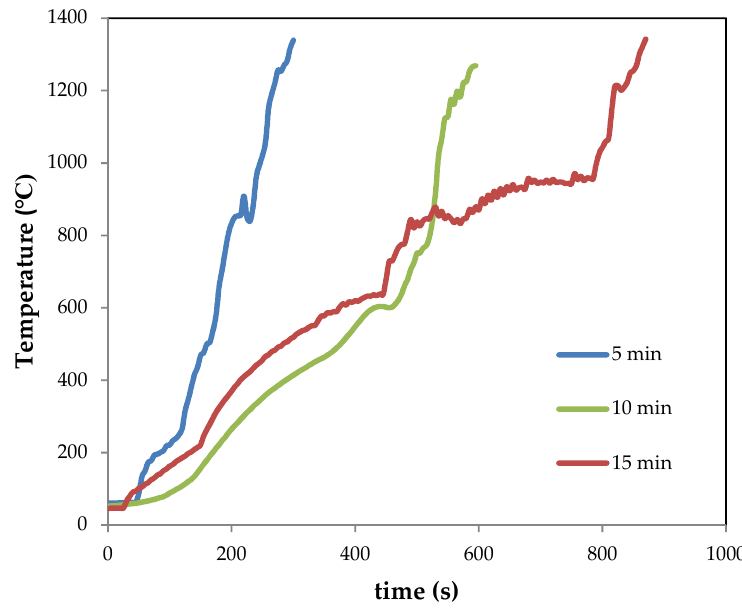
Figure 3. Temperature–time registers for samples M 5 -ES, M 10 -ES, M 15 -ES.